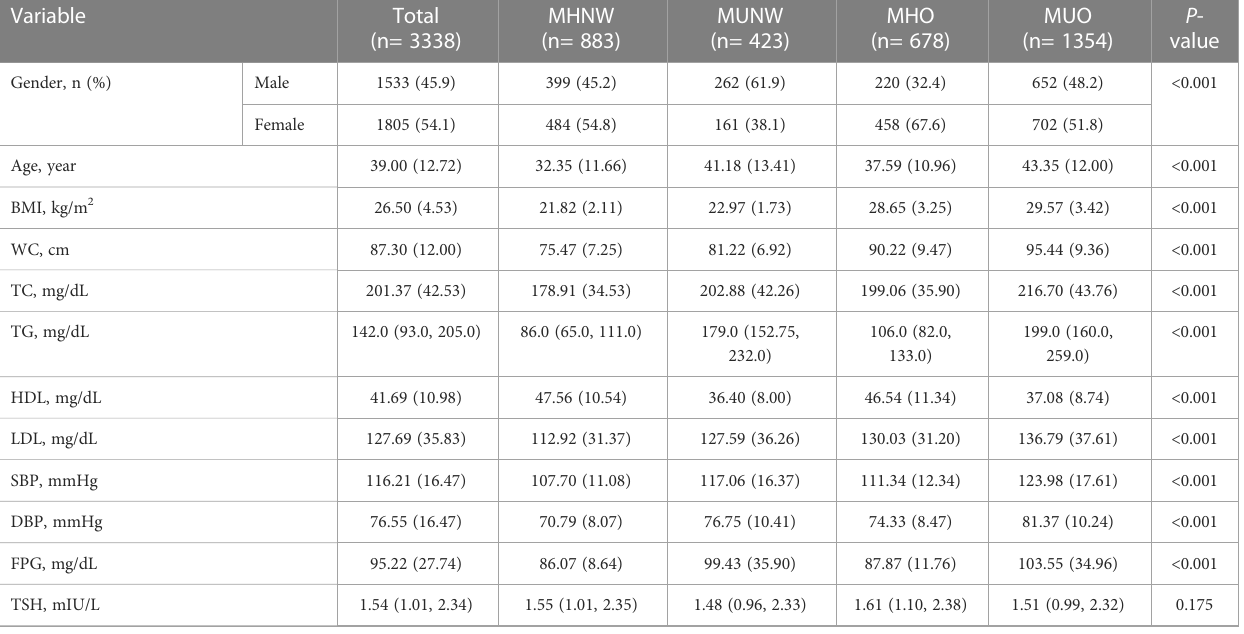
TABLE 1 Baseline characteristics of the study population according to different metabolic phenotypes.